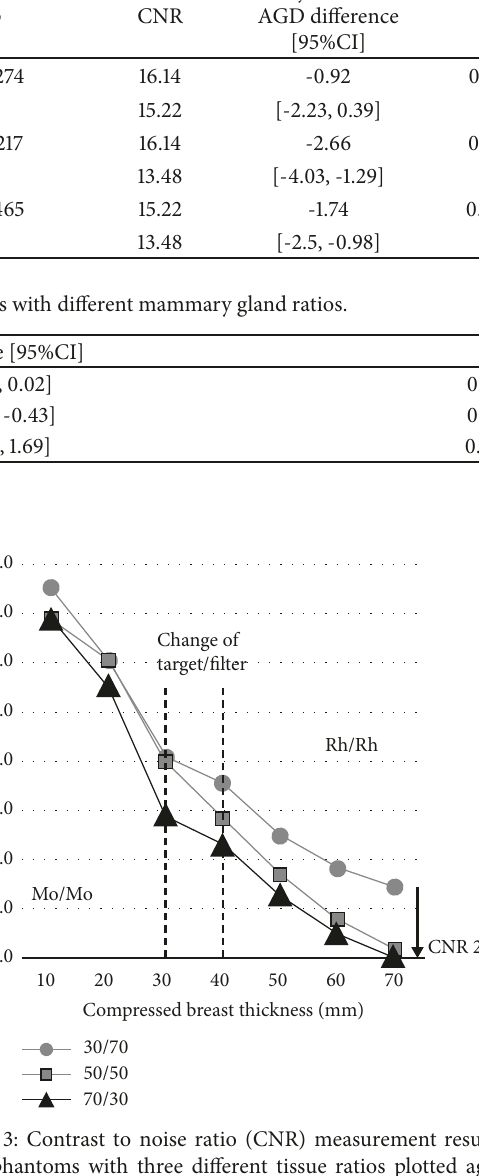
Table 3: Mean CNR for each mammary gland tissue ratio adjusted by the AGD as a covariate. Breast phantom model